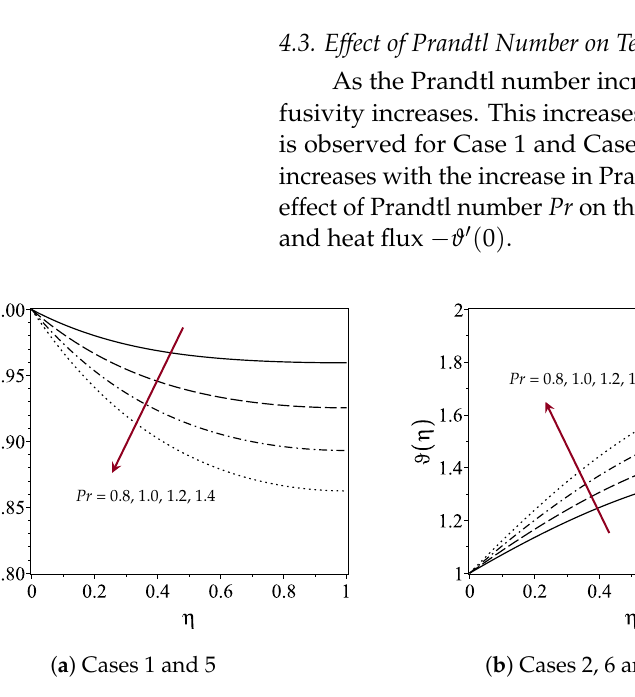
Figure 4. Variation of temperature distribution ϑ ( η ) with Prandtl number Pr at S =4 and G ∗ =1. Table 8. Variation of temperature distribution ϑ ( η ) with Prandtl number at S =4 and G ∗ =1.